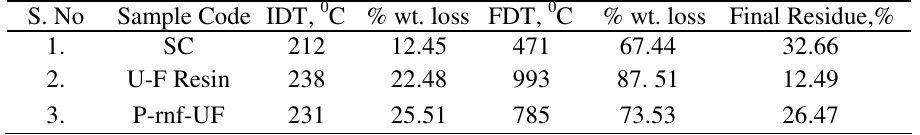
P-rnf= Particle reinforced composite Table 2. Differential thermal analysis of UF, SC and P-Rnf-UF composites S.